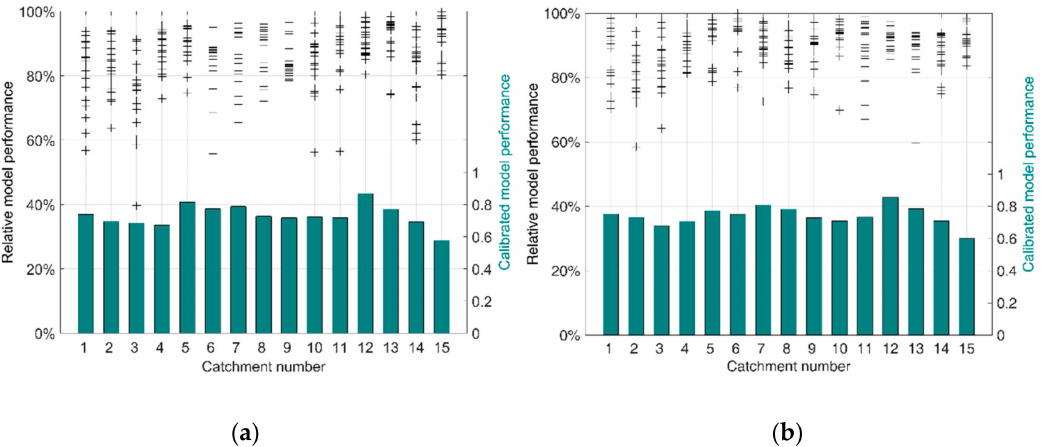
Figure 4. Model performance by individual calibration and transferred parameters from one-year based calibration:( a ) 1970–1979; ( b ) 1980–1989.